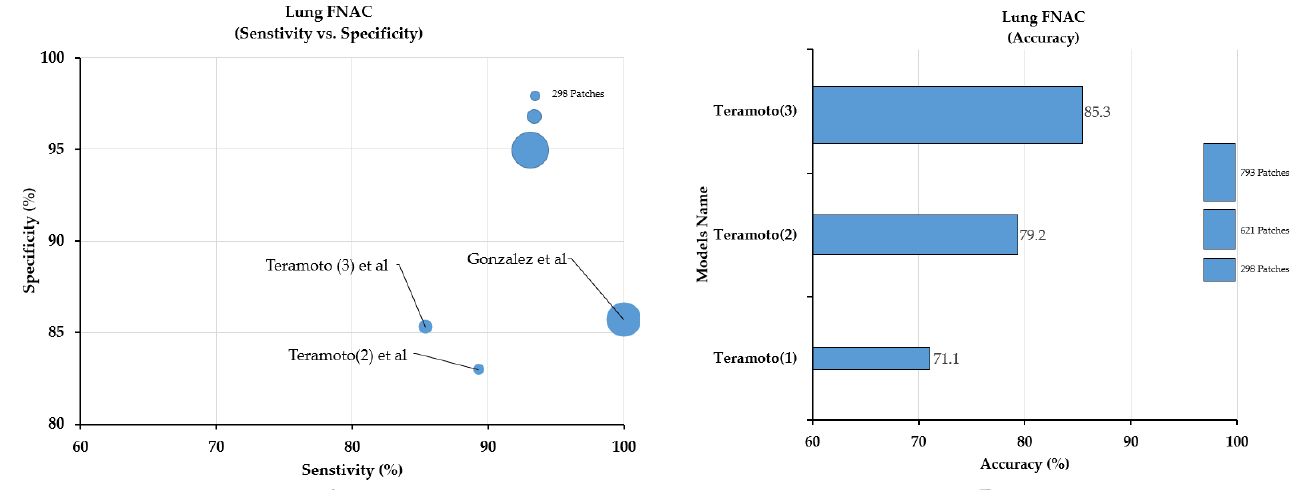
Figure 5. Comparison of sensitivity, specificity ( A ), and accuracy of models ( B ) with respect to lung cytology samples. The model by Gonzalez et al. [28] showed the best sensitivity and specificity, while the models by Teramoto et al. [23] showed the best accuracy.